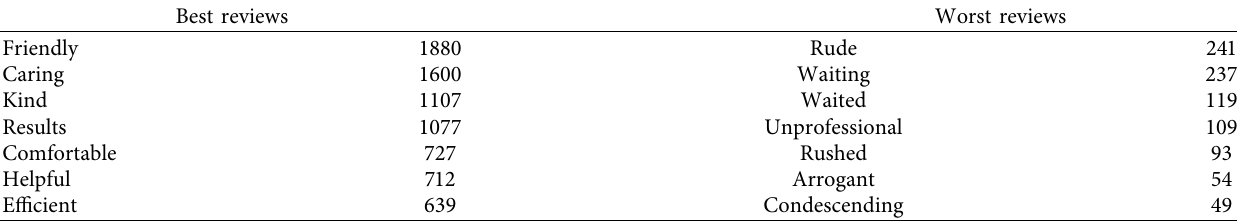
Table 7: Clinically relevant single-word frequency in best and worst